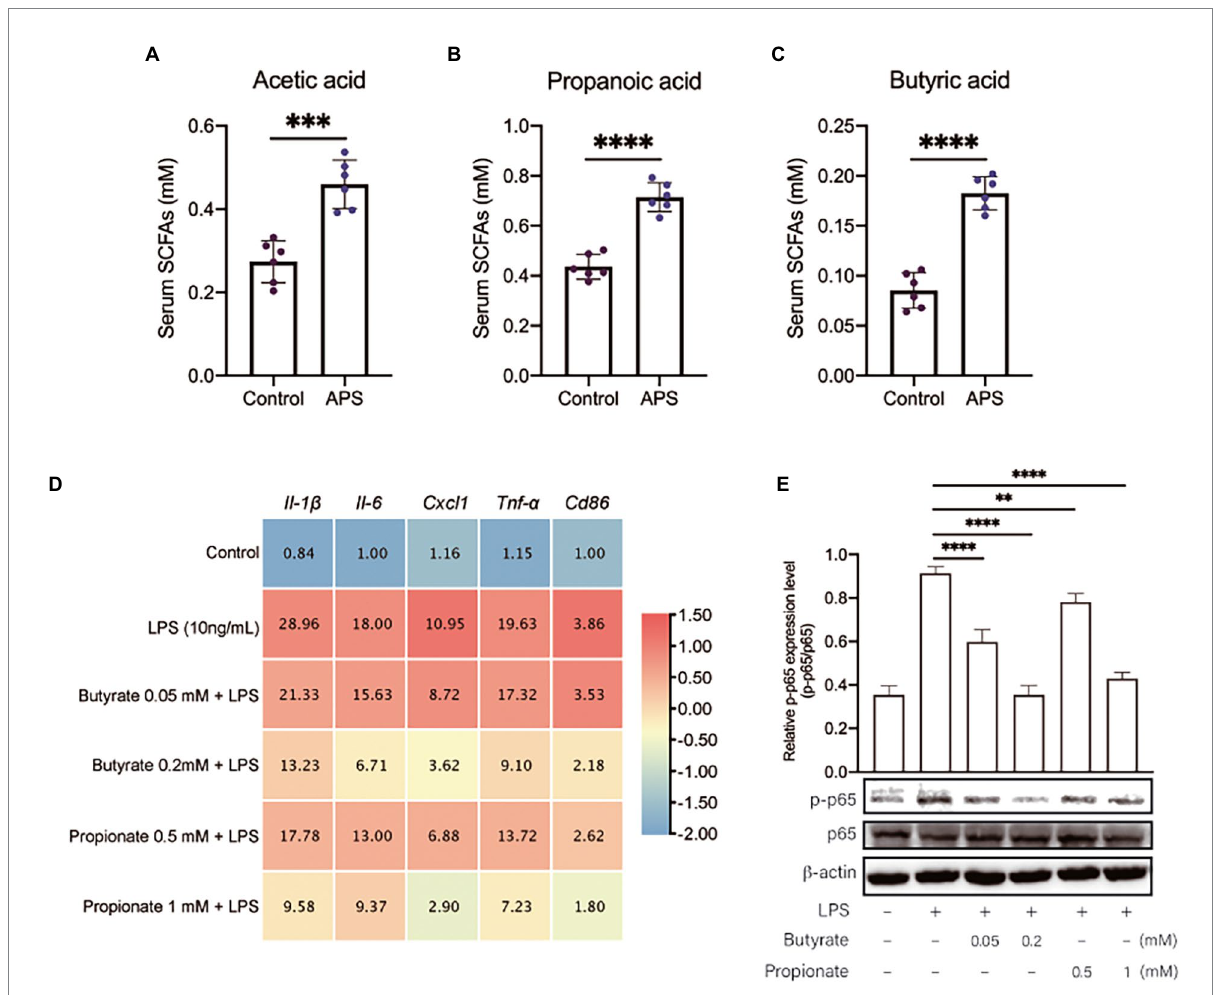
FIGURE 5 APS pre-treatment inhibits lung inflammatory response via increasing the serum concentration of SCFAs. (A) The serum concentration of Acetic acid with n = 6 samples per group. (B) The serum concentration of Propanoic acid with n = 6 samples per group. (C) The serum concentration of Butyric acid with n = 6 samples per group. (D) The heatmap represents the mRNA expression levels of pro-inflammatory markers in primary mice AMs with n = 6 samples per group. Mice primary AMs were pretreated with butyrate (0.05 and 0.2 mM) or propionate (0.5 and 1 mM) for 20 h and then were treated with LPS (10 ng/ml) for 4 h. The relative expression data were normalized by using log scale and column scale, and the heatmap was drawn in TBtools software. The average expression levels were labeled in each cell. (E) The relative p-p65 expression level in AMs